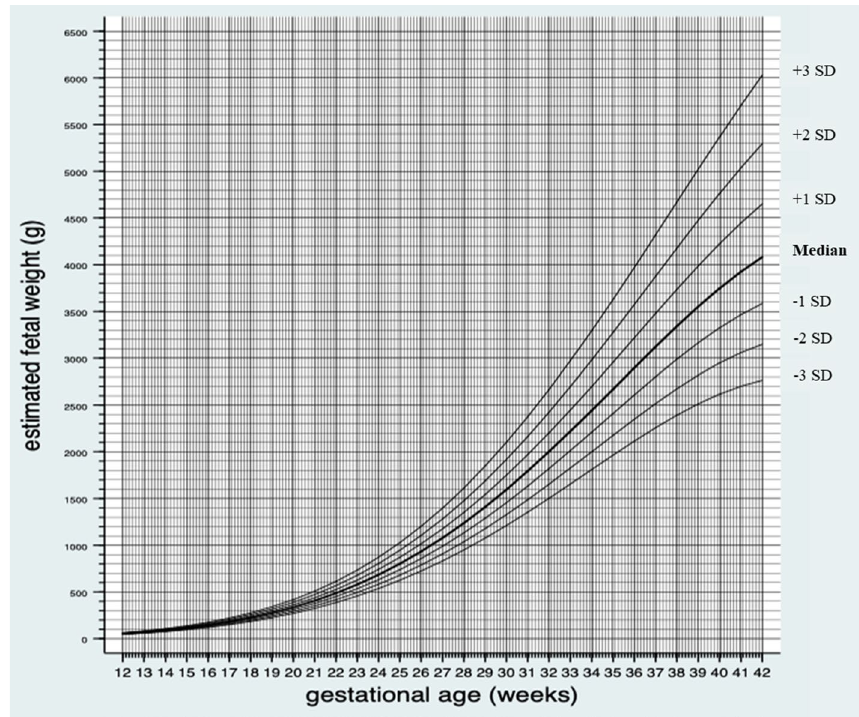
Figure 2. Median and variance in standard deviations (SD) (+ 3 SD, + 2 SD, + 1 SD, median, − 1 SD, − 2 SD and − 3 SD) of estimated fetal weight in grams (g) by gestational age for male and female fetuses.